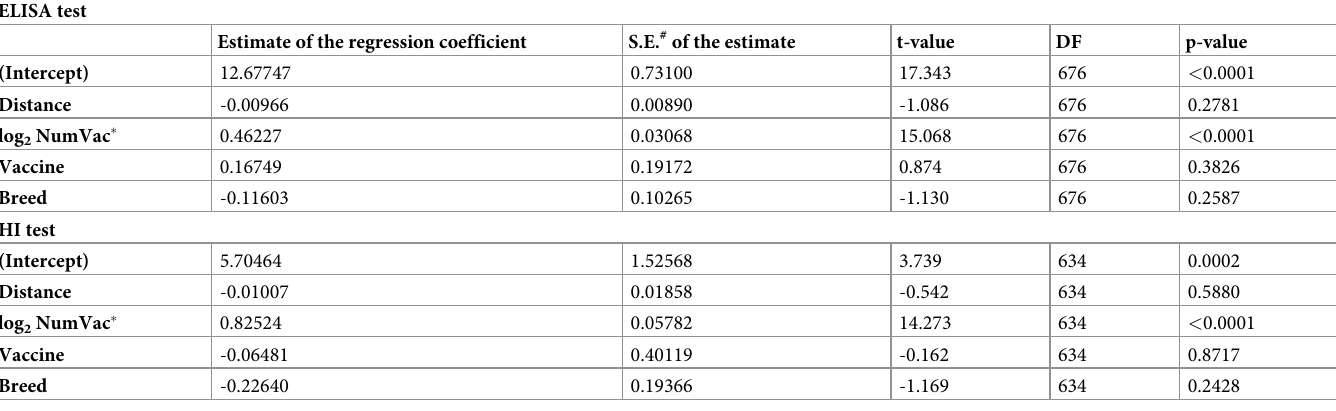
Table 4. Results of linear regression with the partial hierarchical linear mixed effects regression model. ELISA